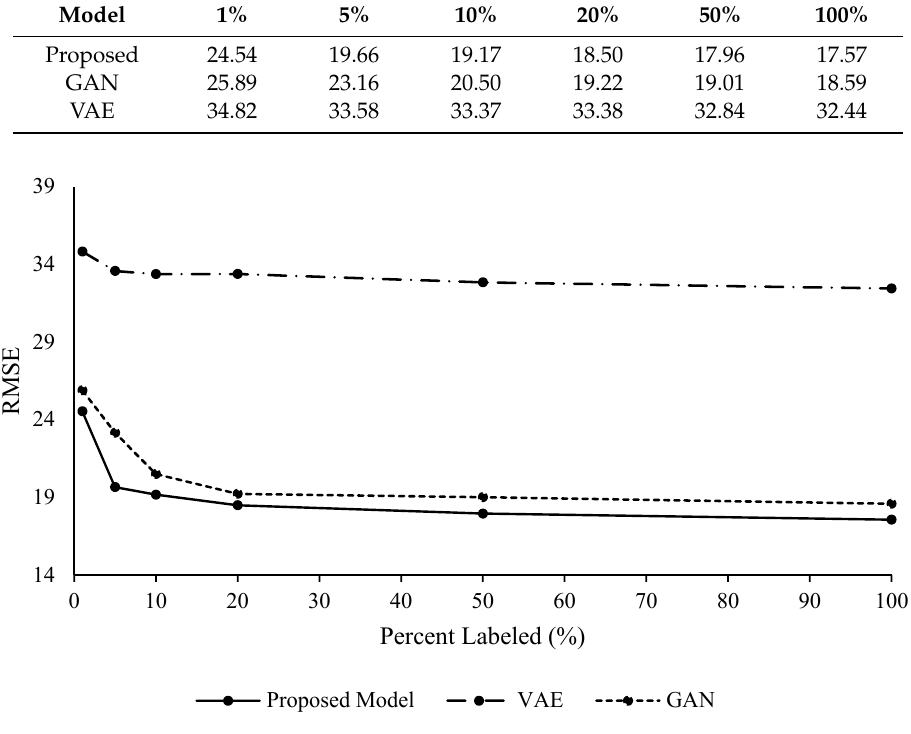
Figure 11. FD001 Unsupervised Feature Learning, Random Labeling Intervals.